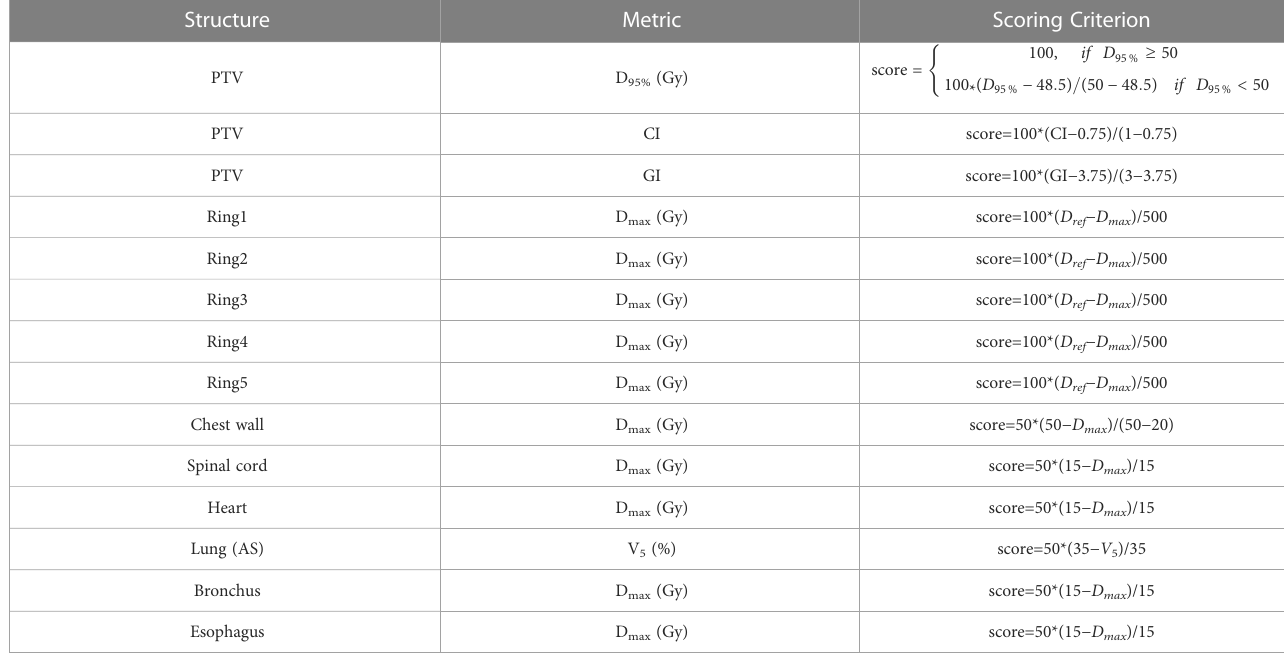
TABLE 1 Plan quality metrics and assigned scores for assessing automatic plan quality. Structure